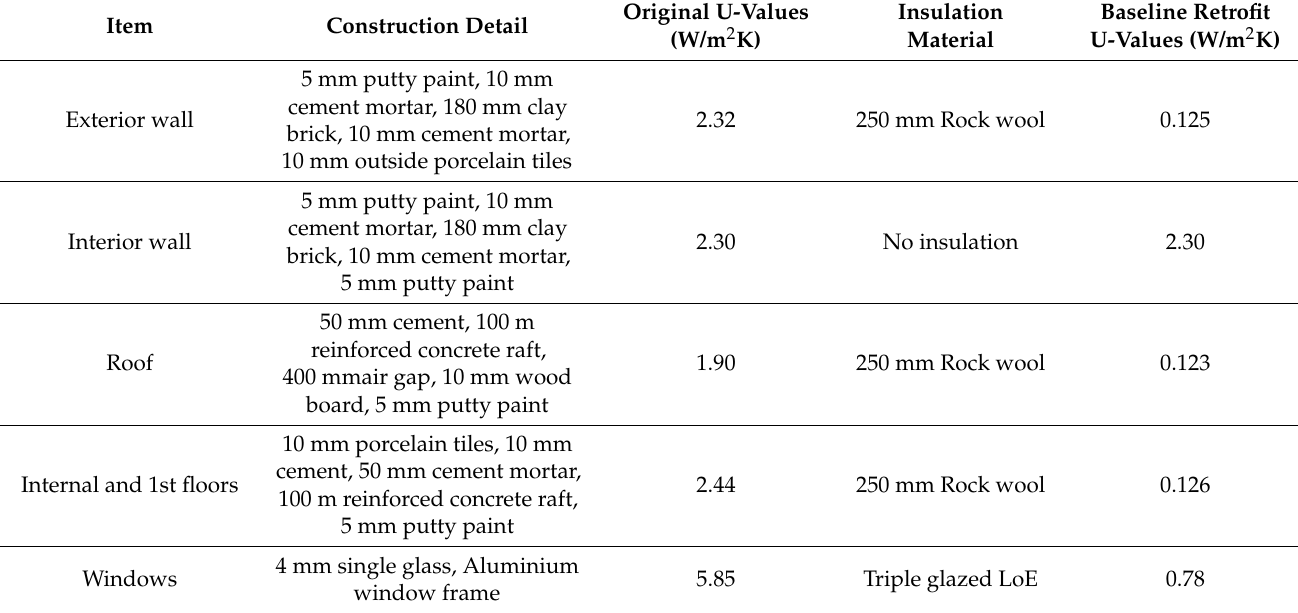
Table 1. The original construction details of the case building and the U-values before and after envelope insulation retrofitting adapted from